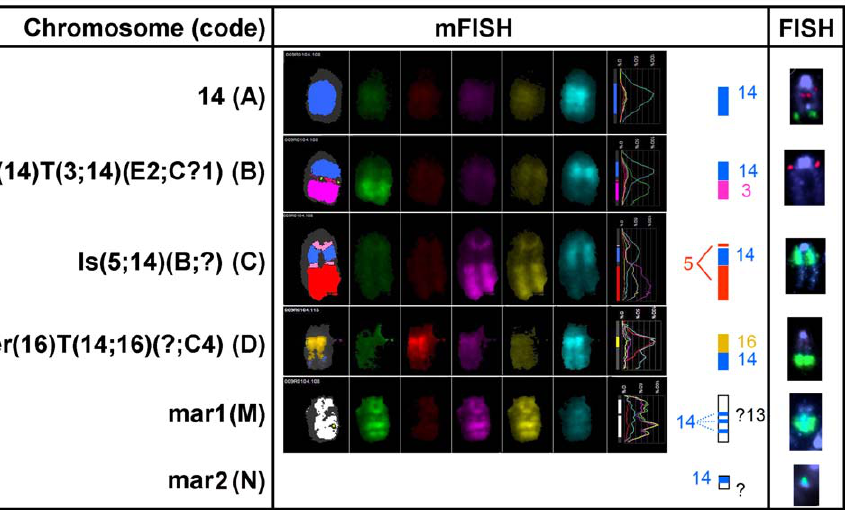
Figure 2. Molecular cytogenetics of relevant chromosomes in wild-type, fully ciprofloxacin-resistant, and revertant macrophages. mFISH and FISH experiments (red: control probe; green: Abcc4 probe) for relevant chromosomes in wild-type macrophages, in the clones of the fully ciprofloxacin-resistant macrophages CR200, and in the revertant macrophages (Rev200). Karyotypes of the cell lines (abnormalities illustrated in the figure are highlighted in bold): a) wild-type cells: 72 , 3n . ,X,der(X)T(X;11)(E or F1;?B5),der(1)T(1;6)(C?;B?3), + der(1)(1A1 R 1C?::6B?3 R 6D , F::X? R X?), 2 3, + der(5;17)(5A1 R 5C2::17A1 R 17?), der(6)T(1;6)(?D;B3), + der(6), + der(9)T(9;19)(?B;C2), + ?Del(12)(?B), 2 13,idic(13), der(14)T(3;14)(E2;C?1) ,idi- c(15), 2 18, 2 19,idic(19),ace(3)x2,ace(18)x2; b) CR200 cells (‘‘idem’’ refers to the chromosomal abnormalities stated in the wild-type cells